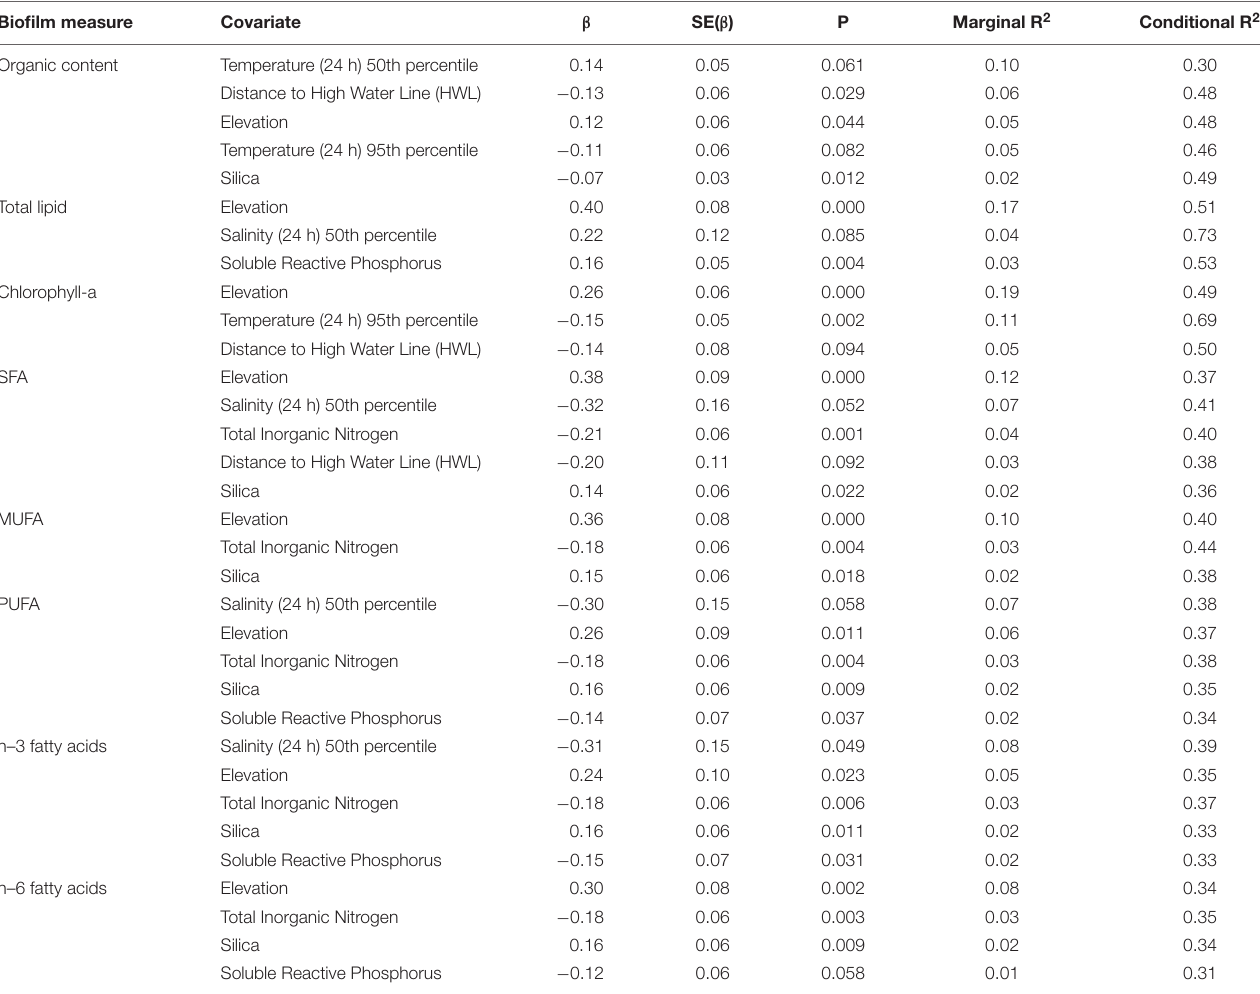
TABLE 3 | Effects of covariates on measures of biofilm organic and fatty acid (FA) content. Biofilm